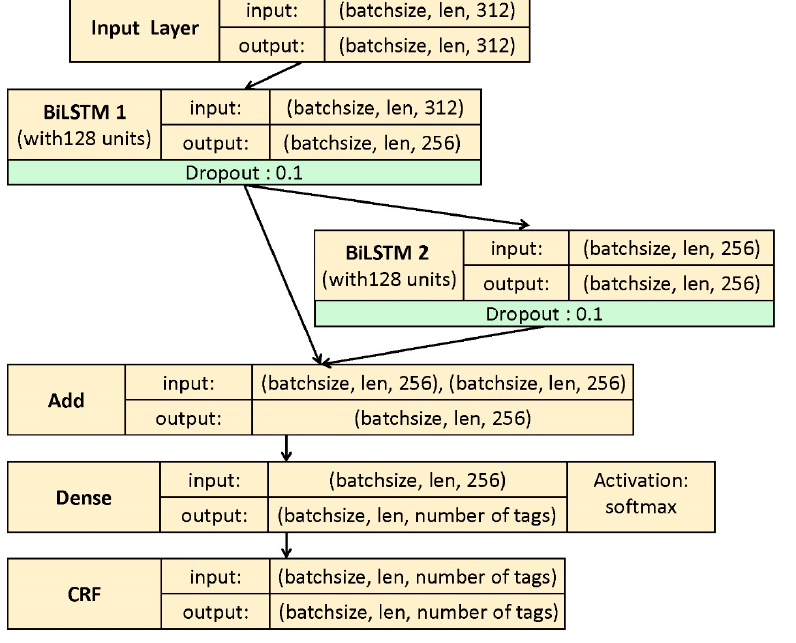
Figure 4. Input and output parameters of the proposed model.